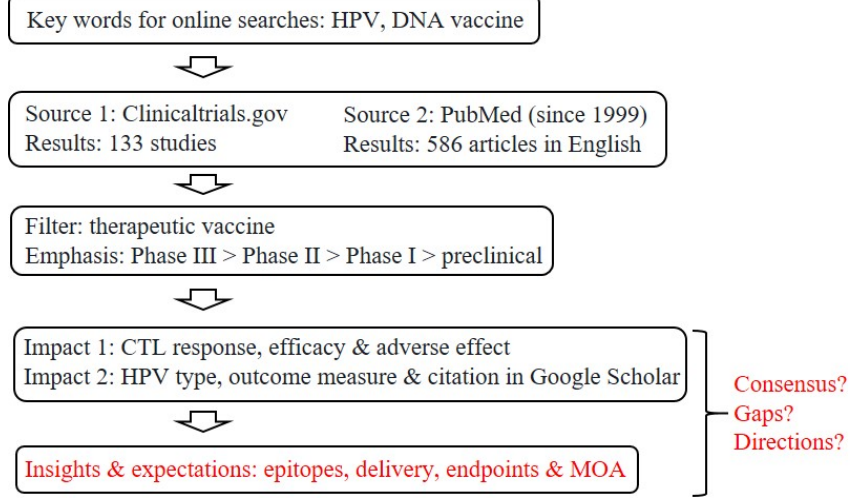
Figure 1. Strategies for screening and filtering current literature for a focused review. Given the large numbers of clinical trials and related literature, as already captured by two major public databases, our goal here is to summarize the current status of research and development toward therapeutic, anti-HPV DNA vaccines, with a focus on insights and expectations, as well as questions about potential consensus, remaining gaps and future directions for refinements or improvements. CTL, cytotoxic T-lymphocyte; MOA, mechanism of action.